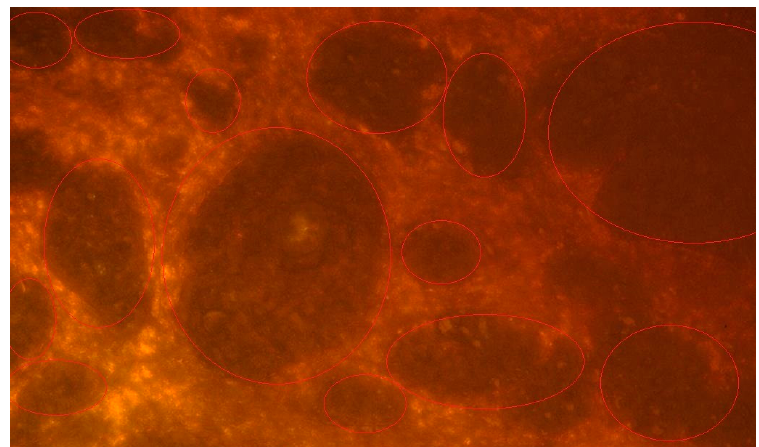
Figure 4. Hyperspectral image of the SCC specimen after staining with EGFR-conjugated GNPs. The location of the GNRs are marked in red.